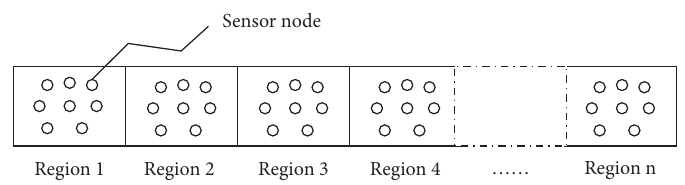
Figure 1: Network structure of railway regional environment.